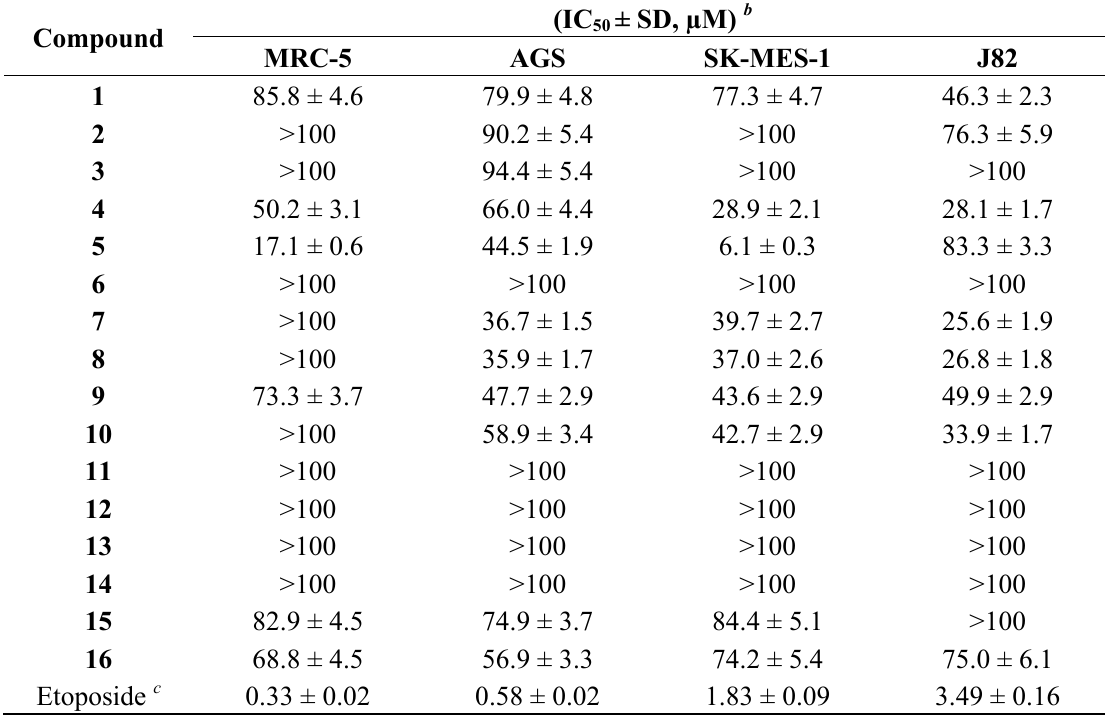
Table 1. Antiproliferative activity of dehydroabietic acid derivatives 1 – 16 against MRC-5 normal fibroblasts and selected tumor cell lines.